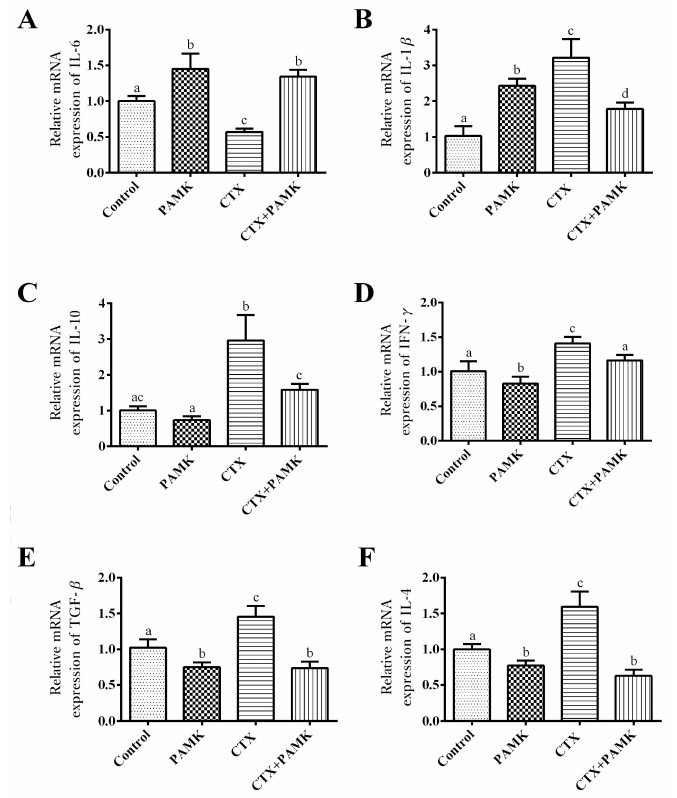
Figure 7. Effects of PAMK on the cellular immunity of geese treated with CTX. ( A ) Relative mRNA expression of IL-6; ( B ) Relative mRNA expression of IL-1 β ; ( C ) Relative mRNA expression of IL-10; ( D ) Relative mRNA expression of IFN- γ ; ( E ) Relative mRNA expression of TGF- β ; ( F ) Relative mRNA expression of IL-4. The data are expressed as the mean ± SD, n = 8. Means with different letters represent statistically significant differences ( p < 0.05); the bars with the same letter are not significantly different ( p >